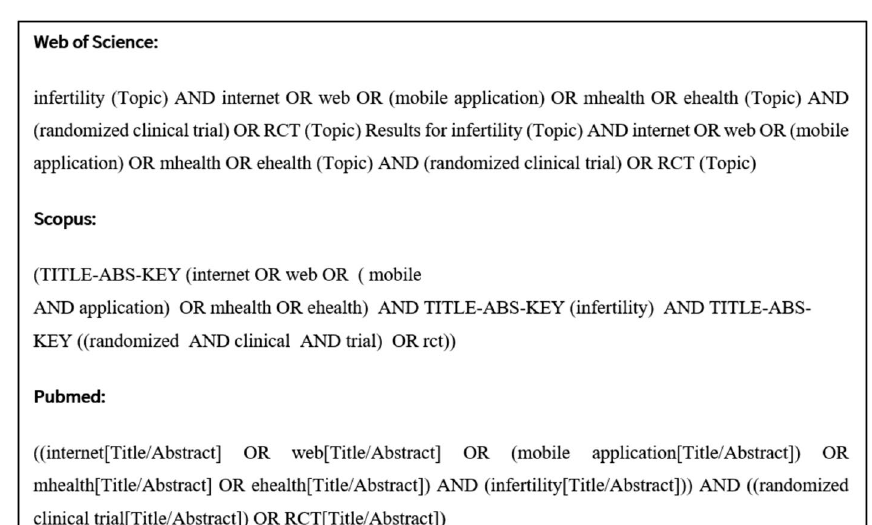
Fig. 1 Search strategy in main